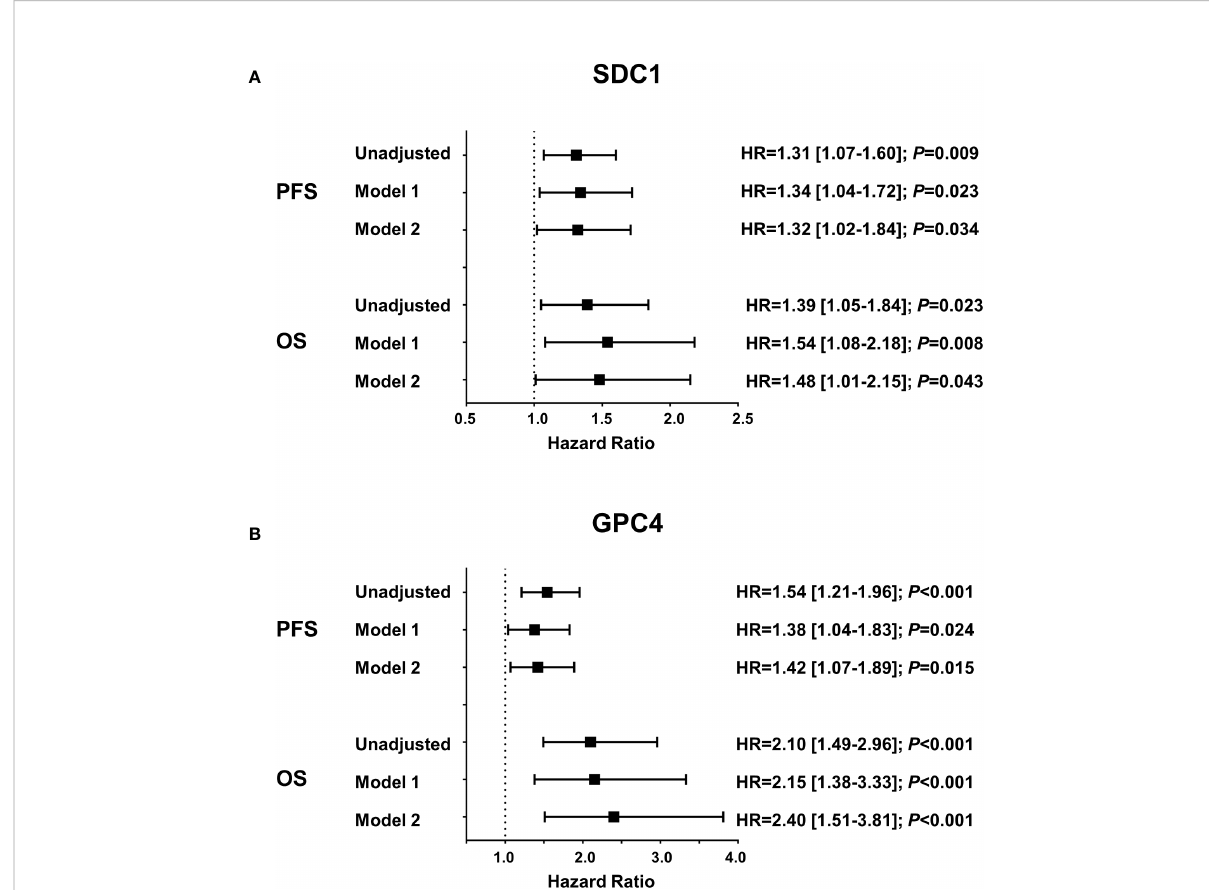
FIGURE 3 Association of plasma SDC1 and GPC4 with progression free survival and overall survival. Results were obtained from Cox proportional hazards regression analyses and are presented as hazard ratios (HR) and 95% con fi dence intervals [CI] for one standard deviation change of (A) SDC1 and (B) GPC4. Model 1 includes age, sex, number of metastatic sites, and scheduled therapy; model 2 additionally includes CEA. PFS, progression-free survival; OS, overall survival; SDC1, syndecan-1; GPC4, glypican-4; CEA, carcinoembryonic